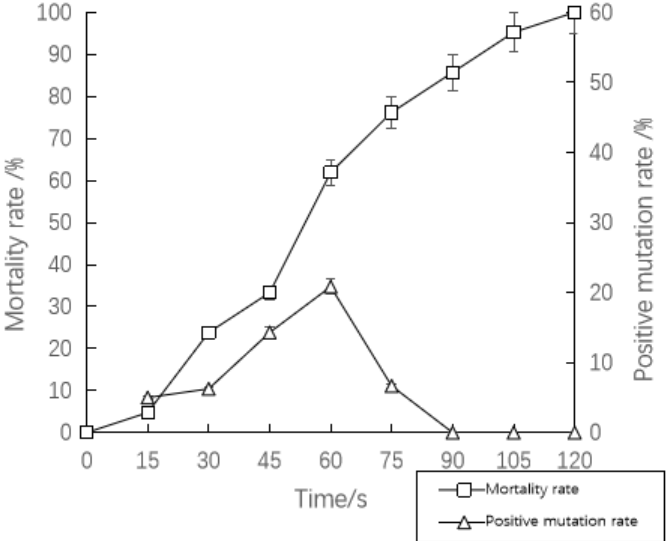
Figure 2. The mortality and positive mutation rate of strain HBUV-22 by microwave mutagenesis. Bars represent standard errors of three replicates.